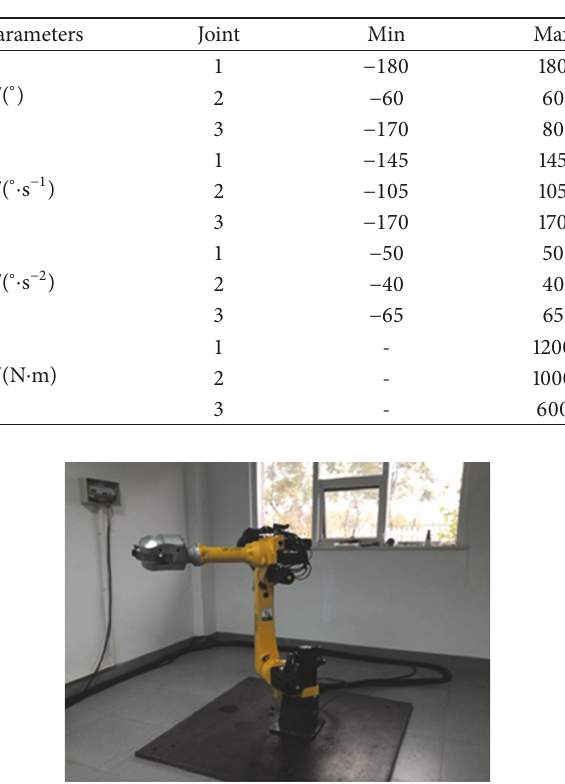
Table 1: Motion constraints of robot.